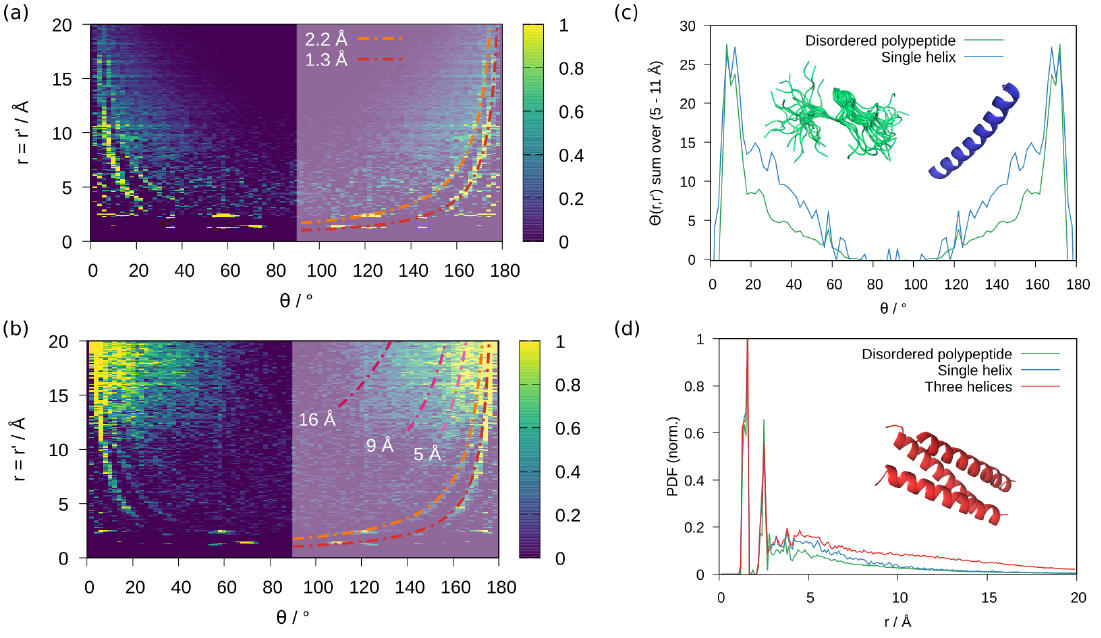
Figure 3. Model PADF plot for α helices. Plots are shown for ( a ) a single helix 40 Å long and ( b ) a bundle of three such helices. ( c ) Comparative sections through the PADF Θ ( r , r (cid:48) , θ ) at r = r (cid:48) = 5–11 Å for disordered polypeptide (green) and single alpha helix (blue) ( d ) Normalised atomic pair distribution functions for 2M5L (green), helix A in 1COS (blue) and all three helices in 1COS (red) as shown below. Cartoon depictions of each of the three models are shown as